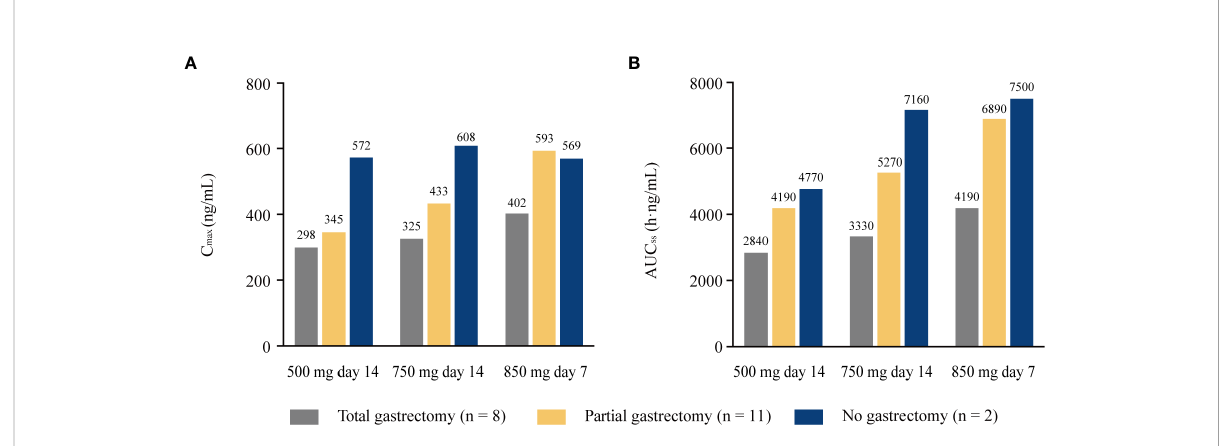
FIGURE 3 Pharmacokinetic parameters of apatinib in the 21 patients completed all plasma sampling over all dose range with different extent of gastrectomy. (A) C max ; (B) AUC ss . C max , maximum plasma concentration; AUC ss , areas under the plasma concentration-time curve at steady state.